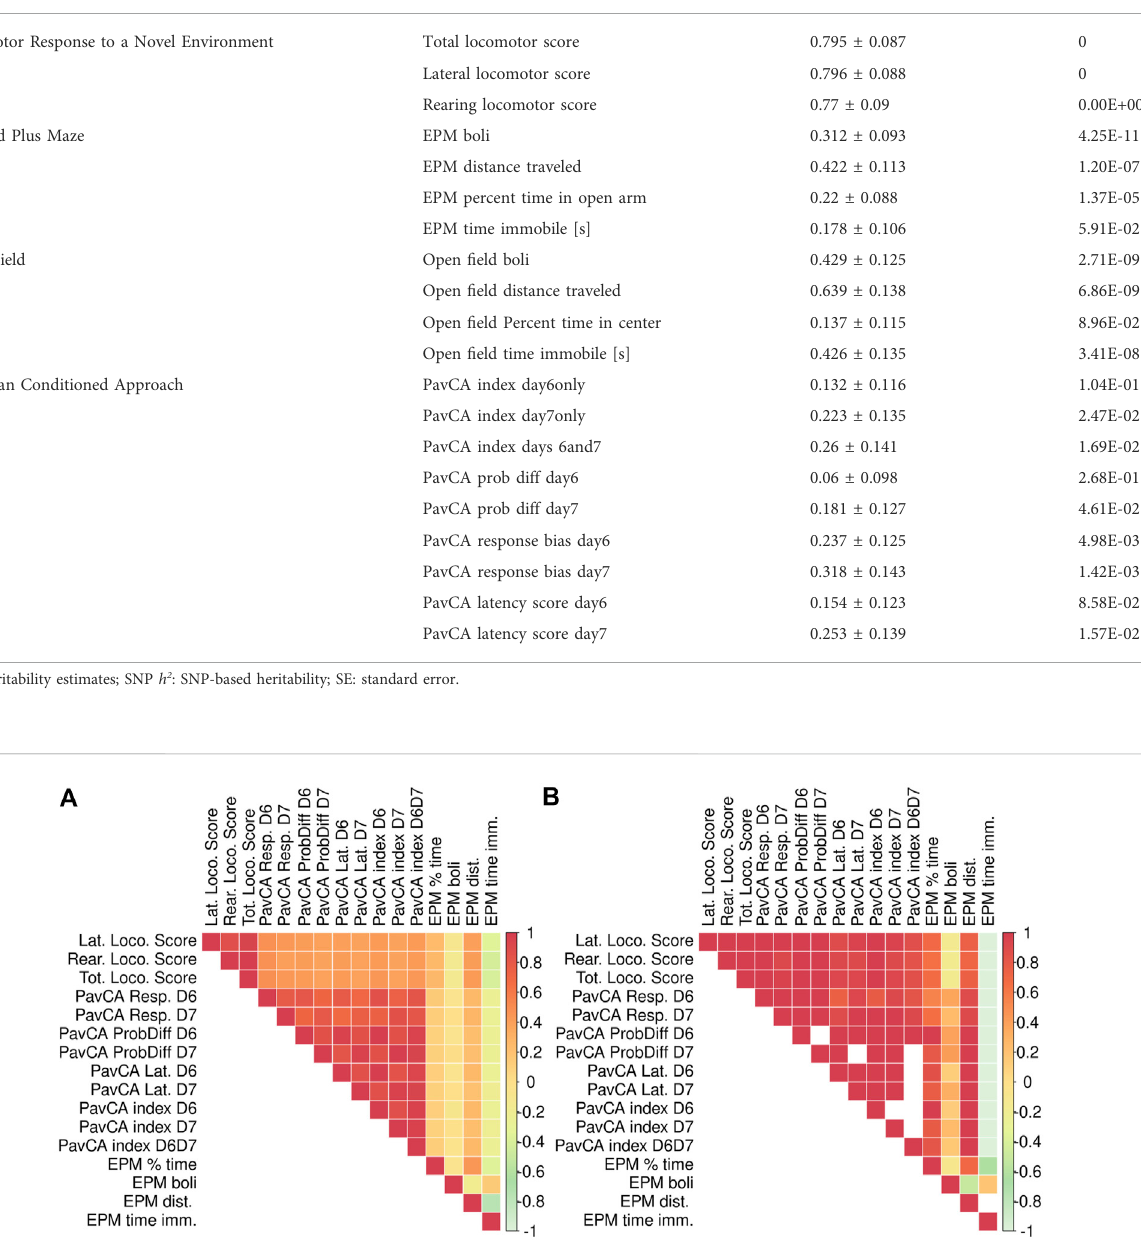
FIGURE 5 Phenotypic and genetic correlations between EPM, PavCA, and Locomotor score traits. Phenotypic and genetic correlations between EPM, PavCA, and Locomotor score (i.e., LocoScore). Phenotypic correlations are depicted in panel (A) , genetic correlations are in panel (B) . We were unable to calculate genetic correlation estimates for certain measures because the REML estimation of genetic correlation using gcta failed to converge. These are represented by blank squares. Phenotypic and genetic correlation estimates as well as the p -values are listed in Supplementary Table